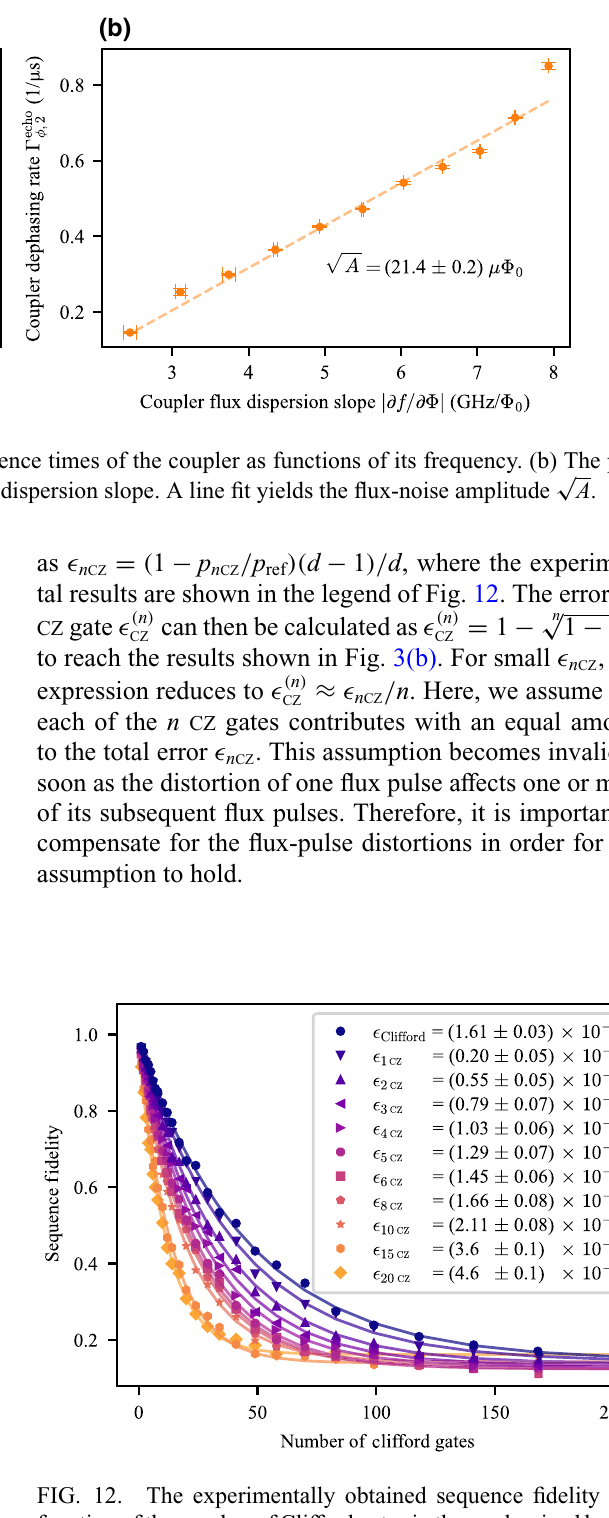
FIG. 12. The experimentally obtained sequence fidelity as a function of the number of Clifford gates in the randomized bench- marking sequence with n interleaved CZ gates, where n ranges from 1 to 20. Each data point (symbols) represents the average result of 30 random sequences. Each sequence fidelity trace is fitted using an exponential model (solid lines) to extract the error (cid:8) n CZ per n CZ gates.